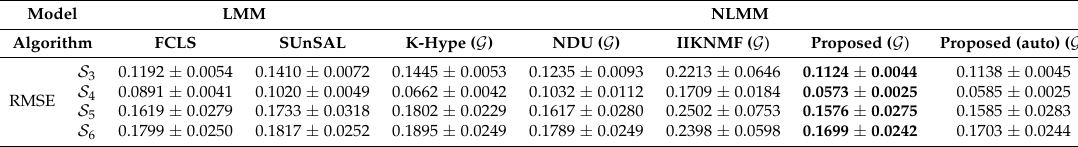
Table 3. RMSE comparison of S 3 , S 4 , S 5 , S 6